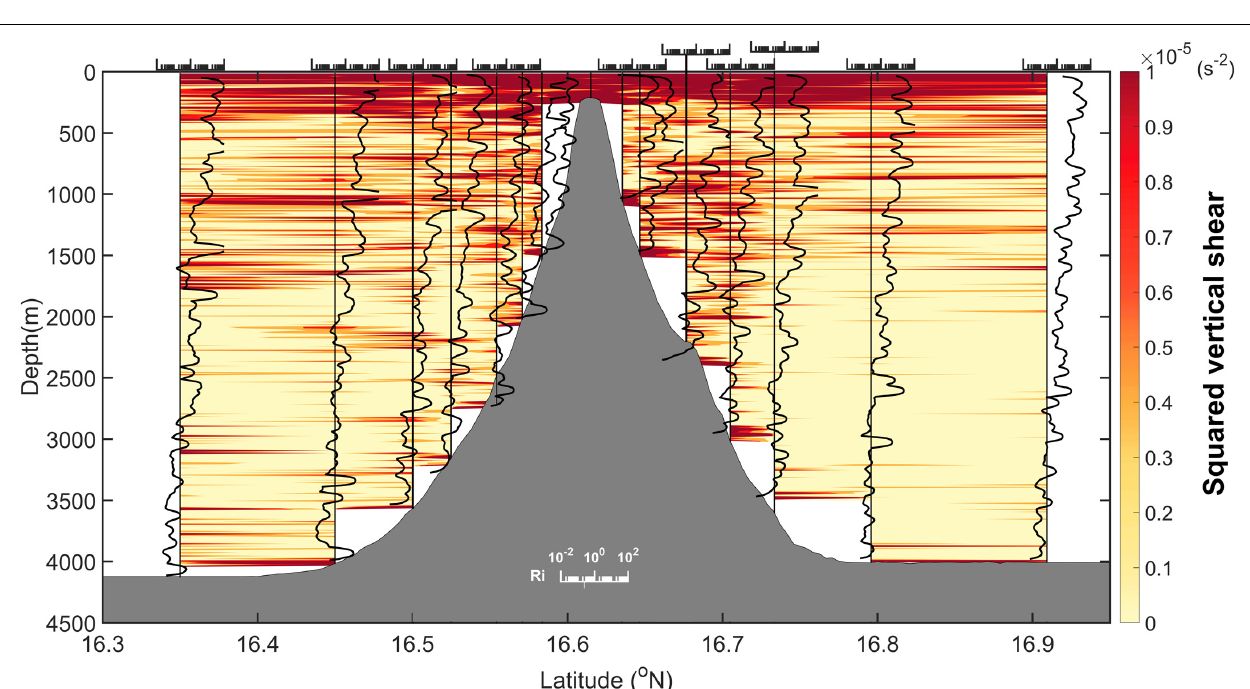
FIGURE 3 | (A) Profile of the potential density (reference pressure of 2,000 dbar) obtained from station P3 at the seamount. (B) Profile of the potential density corresponding to the depth range indicated by the two black horizontal lines in panel (A) . The black curve indicates the original potential density profile, whereas the red curve indicates the sorted potential density.